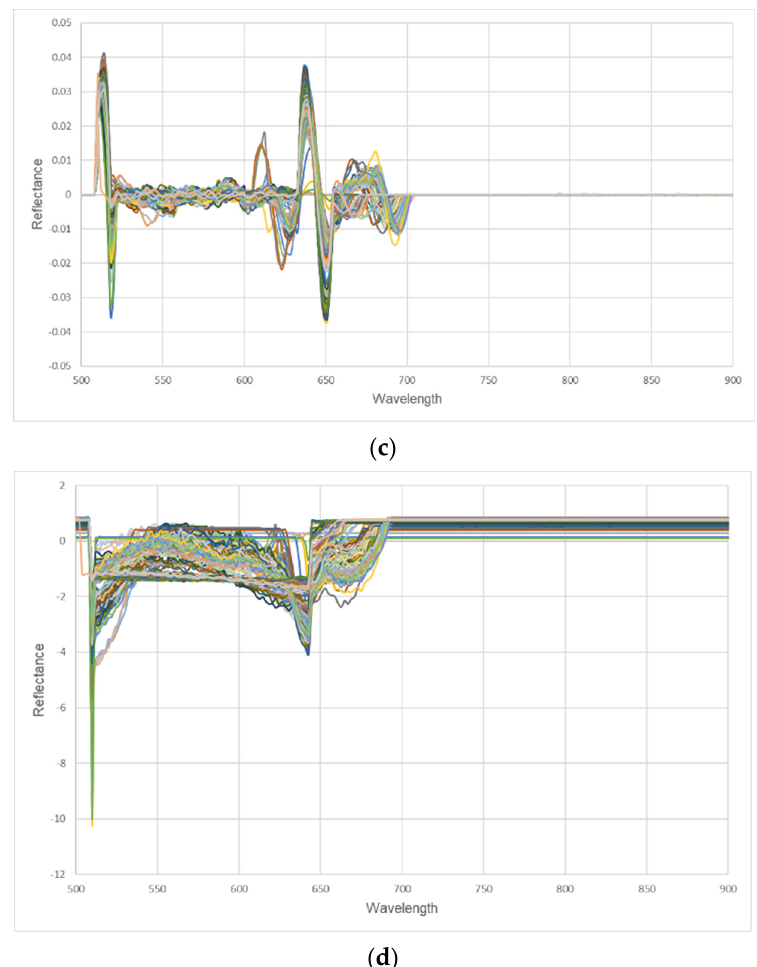
Figure 6. Results of the different pretreatment methods used: ( a ) MSC, ( b ) SGolay1, ( c ) SGolay2, and ( d ) SNV.